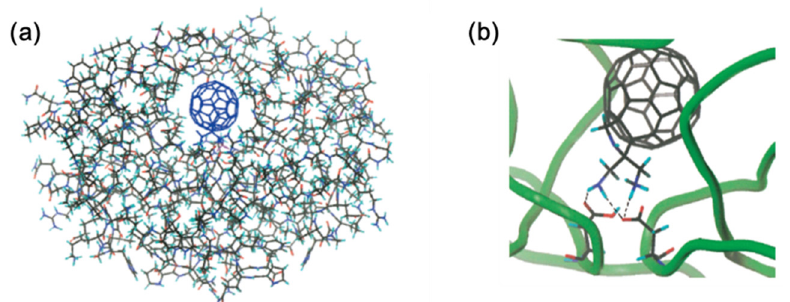
Figure 4. Computer-simulated interactions between compound 3 and HIVP. ( a ) Accommodation of compound 3 in the cavity of HIVP. ( b ) Closer view of the complex of compound 3 and HIVP. Adapted with permission from Ref. [52]. Copyright 2000 American Chemical Society.